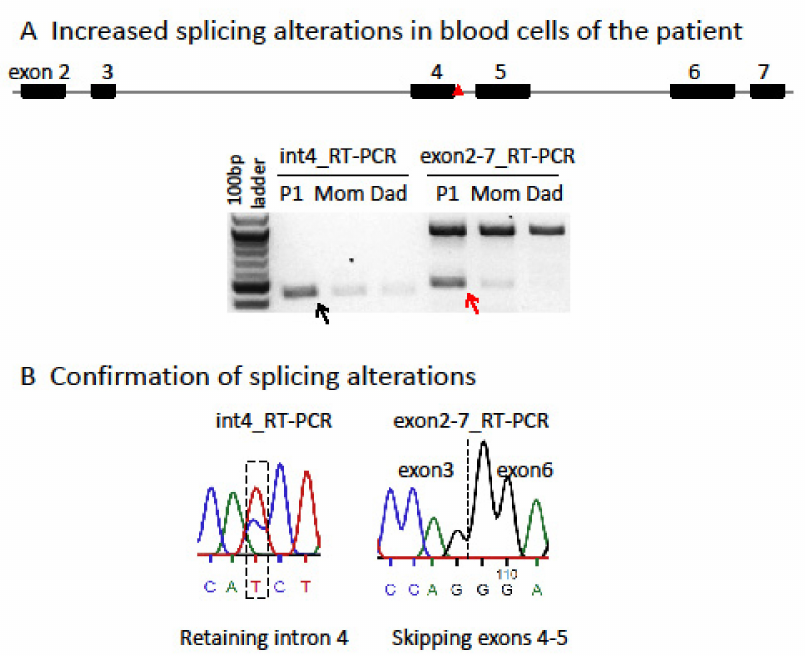
Figure 1. The SMC1A splice-site variant in P1 impacts transcriptional splicing. ( A ) c.615+5G>A (red triangle) in intron 4 strongly increases two alternative splicing events in P1, retaining intron 4 (black arrow; 438 bp) and skipping exons 4–5 (red arrow; 479 bp), as shown by RT-PCR using primer pairs specific for intron 4 transcript or spanning exons 2–7 and RNA from whole blood of the P1 family trio. The large band for the wild-type transcript containing exons 4–5 detected by primer pairs spanning exons 2–7 is 922 bp. ( B ) Sanger sequencing of RT-PCR products confirms these two alternative splicing events. Both abnormally spliced transcripts cause frameshifts and premature translational stop codons and thus cannot produce functional proteins, consistent with loss of function (see Table S2).